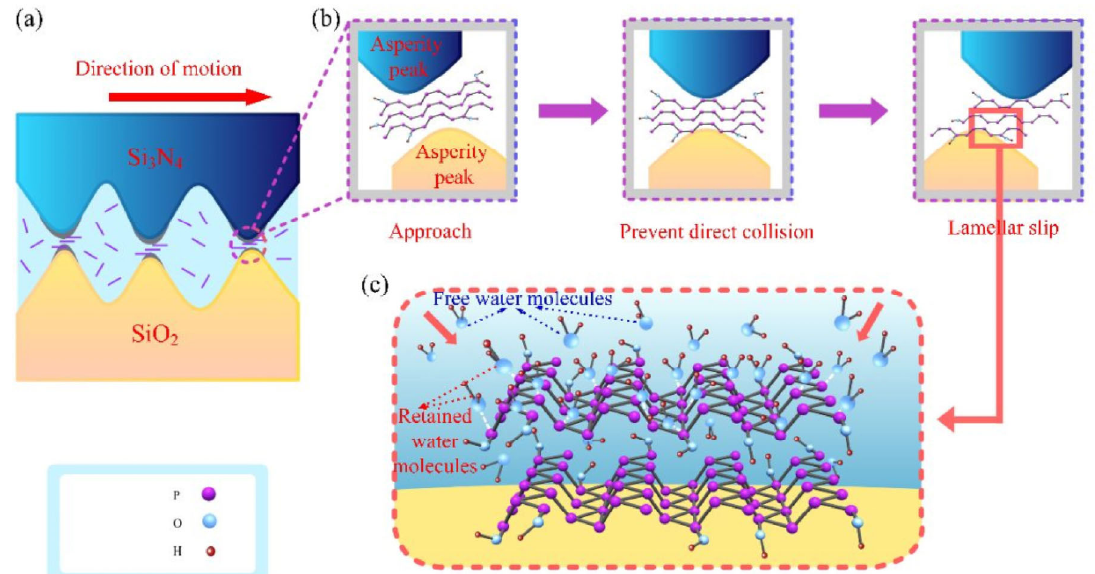
Fig. 12 Superlubricity in the aqueous solution with BP-OH nanosheets. Reproduced with permission from Ref. [145]. © American Chemical Soeity,